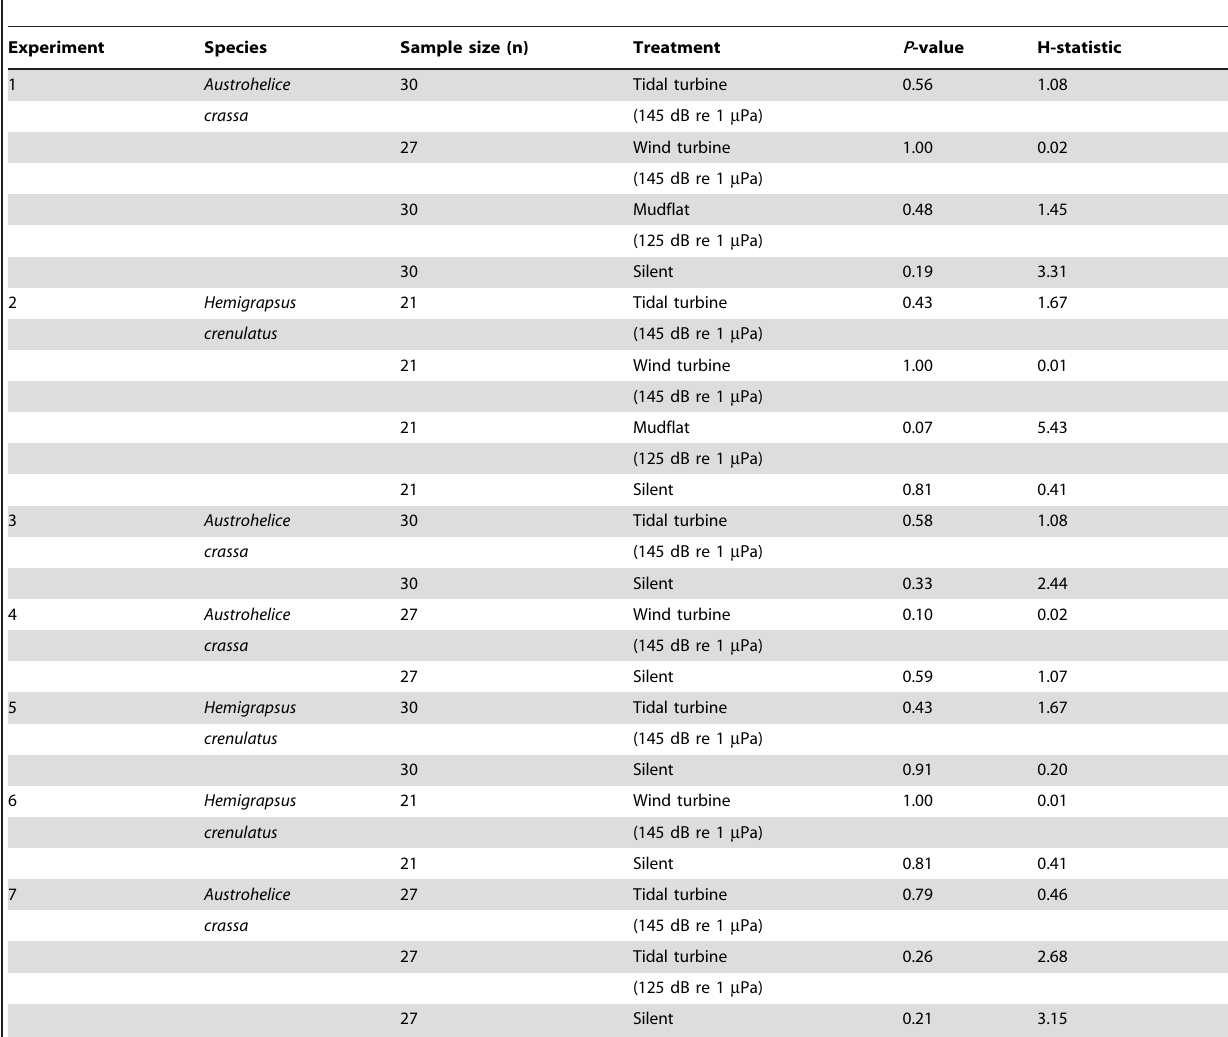
Table 1. Summary from seven individual experiments of comparisons of median TTM values among replicates within each